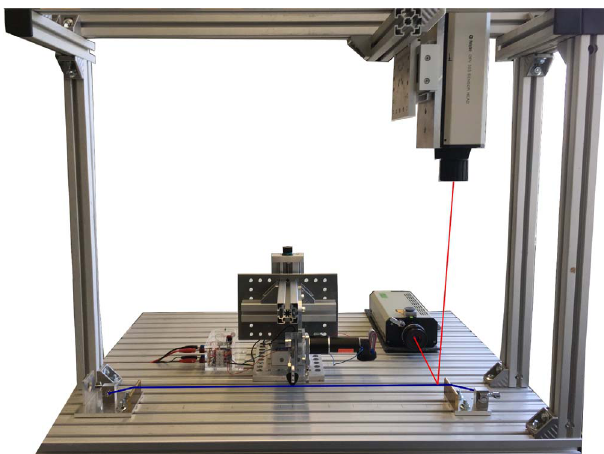
Figure 1. Experimental set-up of the string with two LDVs and automatic excitation